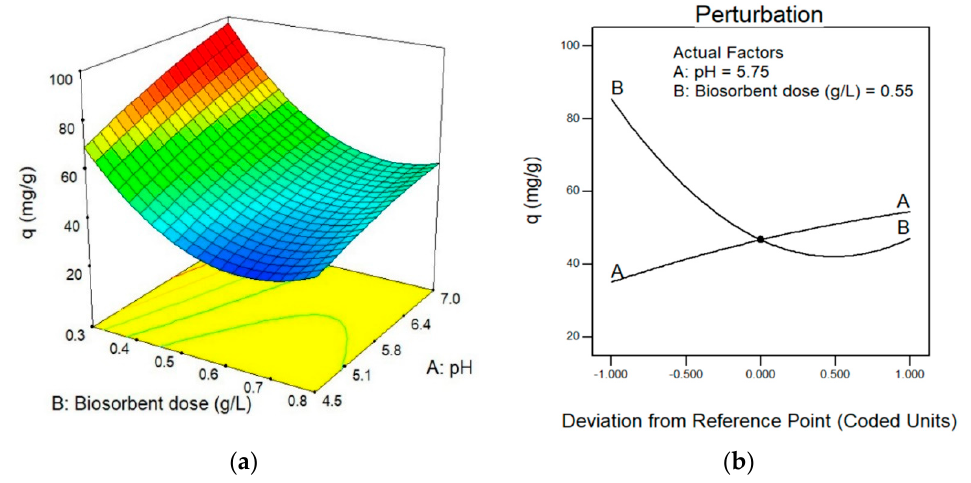
Figure 1. ( a ): Response surface plot for silver biosorption by Rhodotorula mucilaginosa 1S1 at 27 °C and initial silver concentration of 100 mg/L. Effect of the factors studied on the biosorption capacity (q e ). ( b ): Perturbation plot showing the effect of pH (A) and dose of biosorbent (B) on the equilibrium biosorption capacity of silver (q e ).